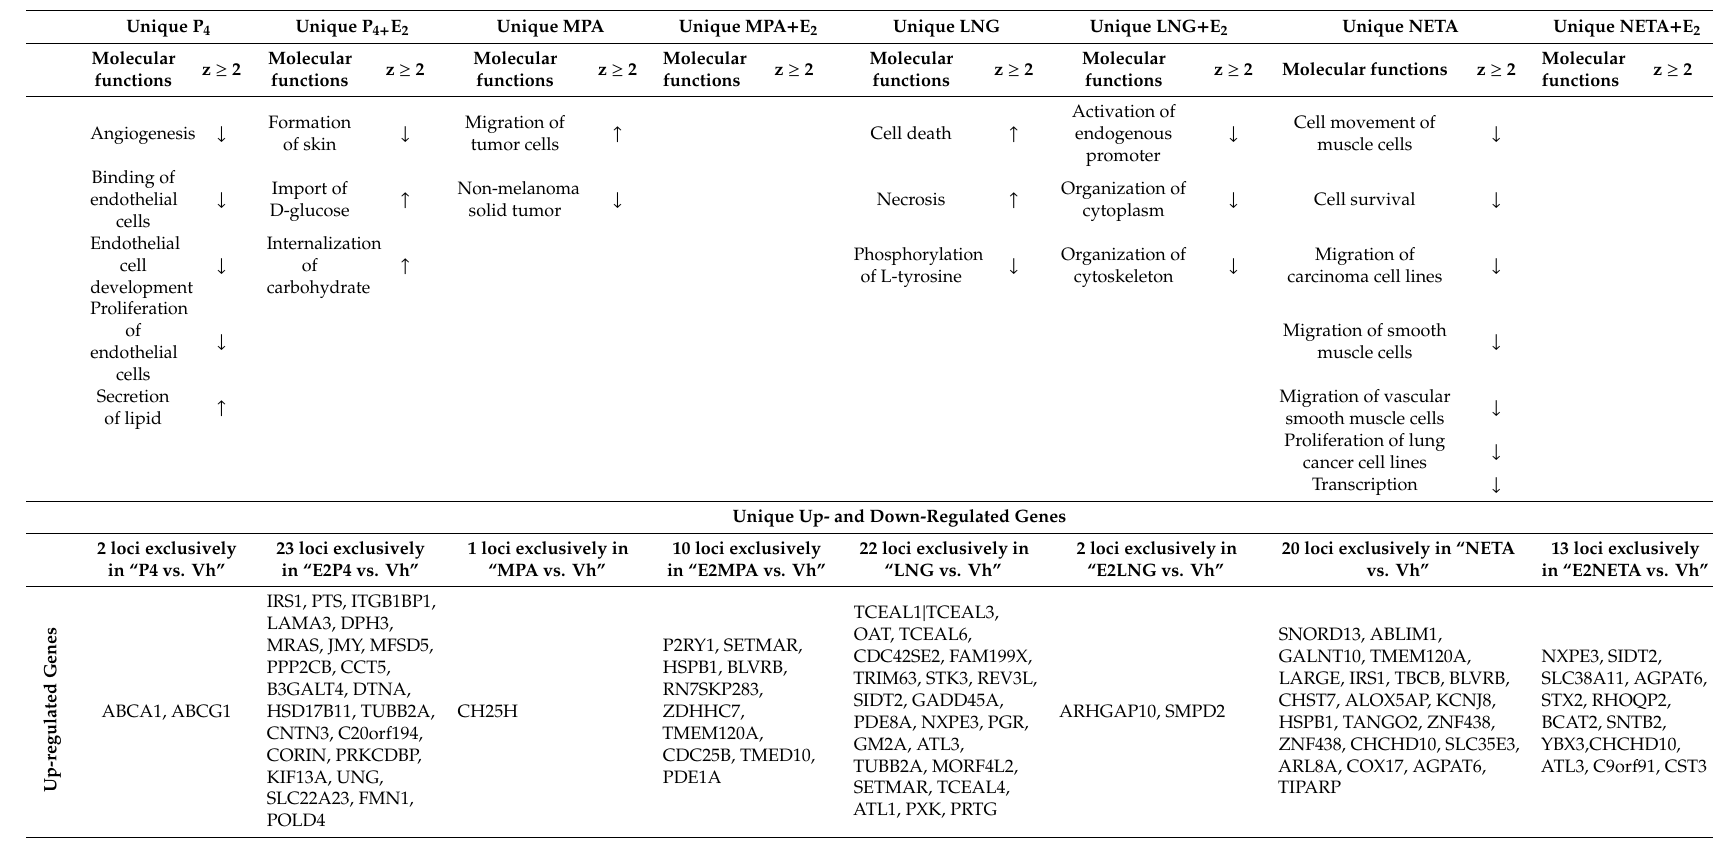
Table 4. Unique molecular functions and genes of each progestin without or with addition of E 2